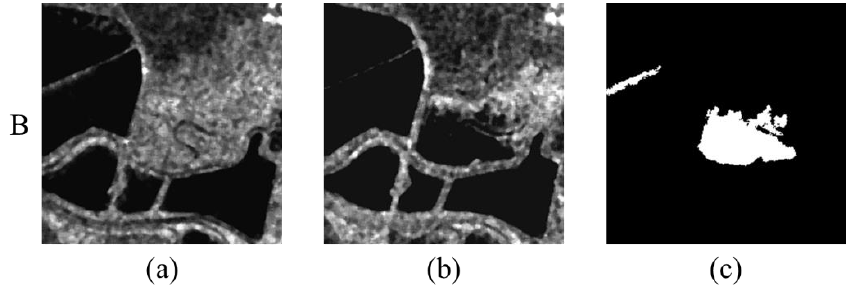
Figure 6. San Francisco dataset. ( a ) Image acquired in August 2003. ( b ) Image acquired in May 2004. ( c ) Ground-truth map.